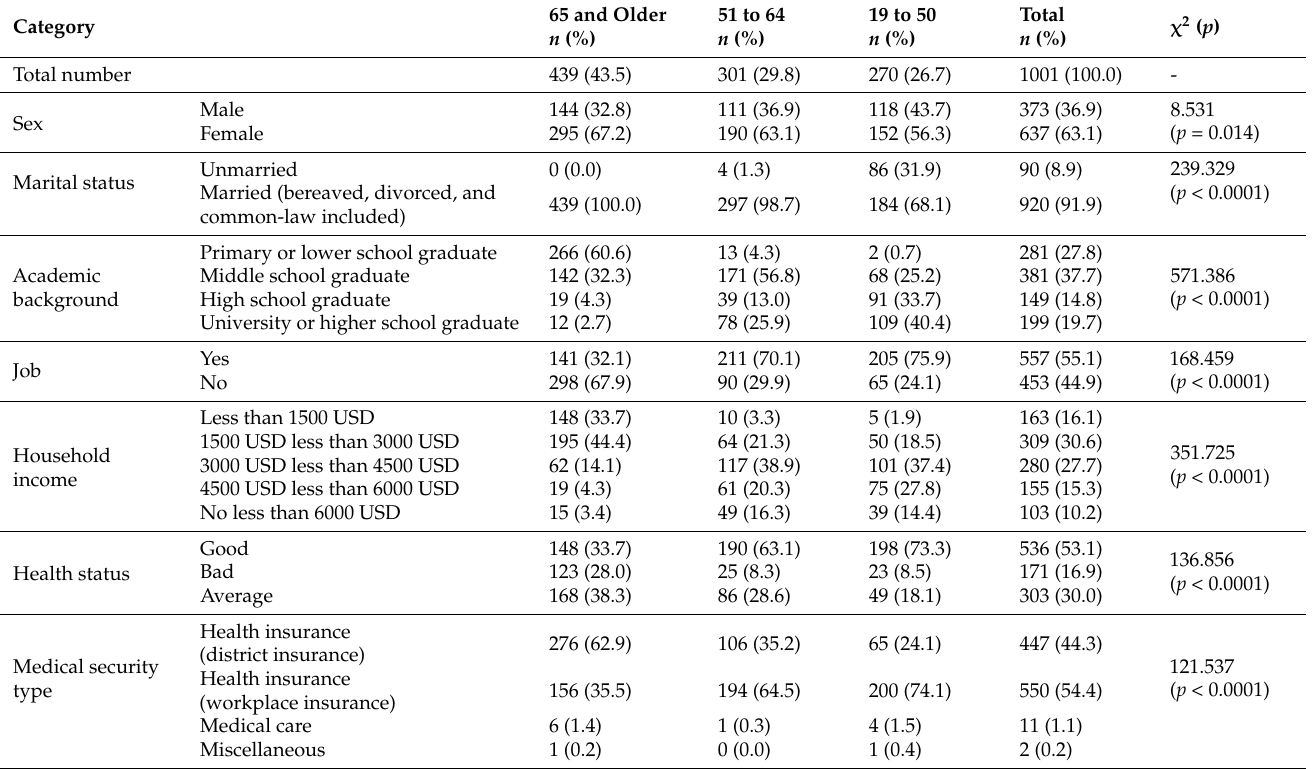
Table 1. Information and characteristics of the older adult group (65 years and older) and general population group (19–50 years).